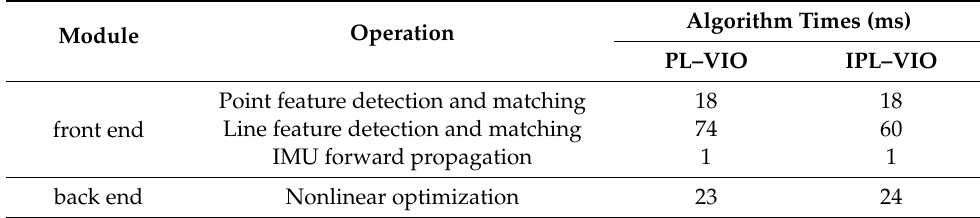
Table 4. The running time of each module of PL–VIO and IPL–VIO.